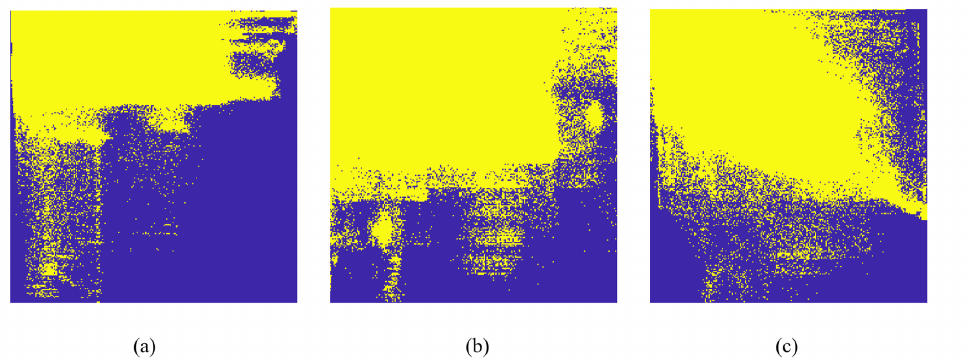
Figure 14. The joint histogram. ( a ) IGM geometric correction; ( b ) GPS+IMU geometric correction; ( c ) GPS+IMU geometric correction with registration. Blue is the background, and yellow dots represent shared pixels in the joint histogram. Table 3. The accuracy evaluation of mosaic